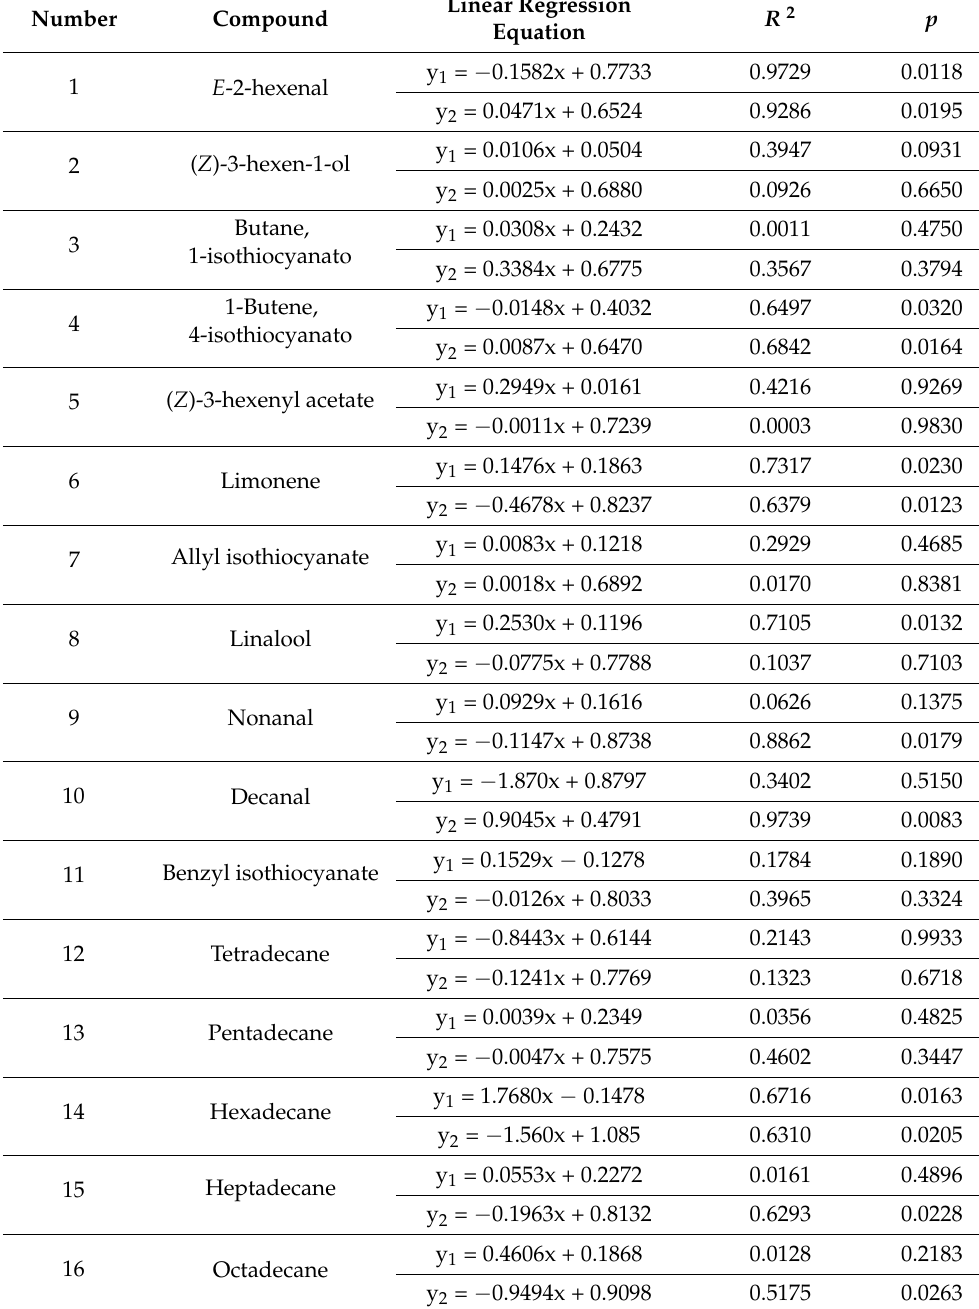
Table 2. Linear relationships between quantities of specific volatiles emitted by Chinese cabbage plants under different treatments and the selection rates of M. similis and S. litura